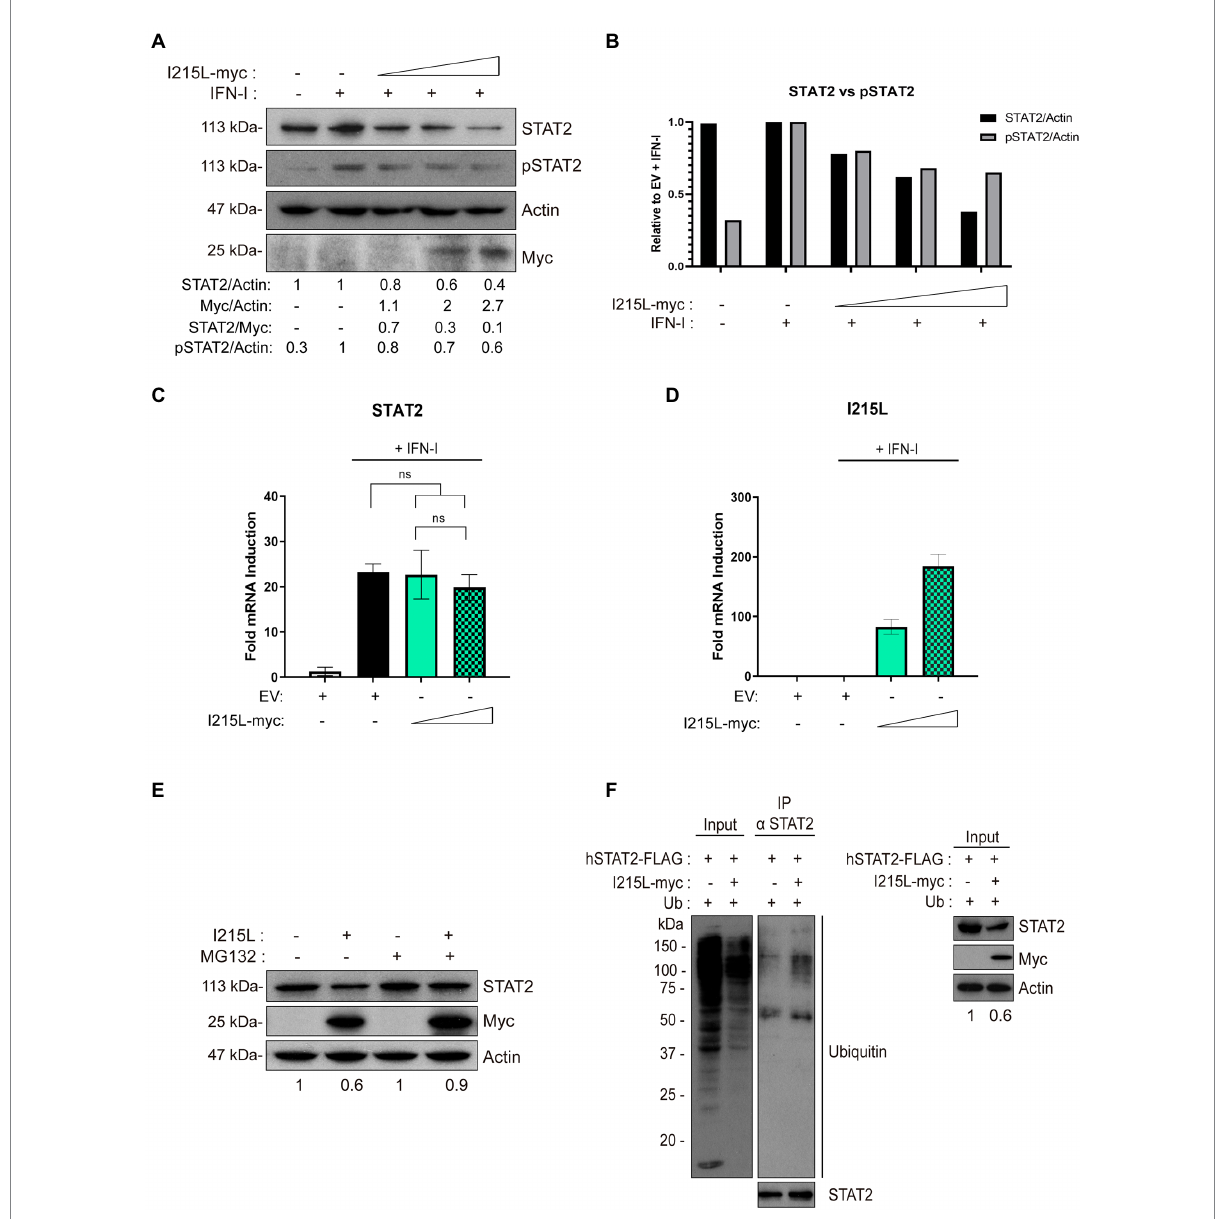
FIGURE 3 pI215L induces STAT2 ubiquitination and degradation. (A) STAT2 and pSTAT2 levels were analyzed in presence of increasing concentrations of pIRES-I215L-myc (0.25, 1, or 2.5 μ g/1 × 10 6 cells) or EV (2.5 μ g/1 × 10 6 cells) in HEK-293 by Western blot assay. Antibodies against STAT2, pSTAT2, myc and actin were employed. STAT2, pSTAT2, and pI215L-myc levels were quantified according with their actin levels and relativized with the EV control using ImageJ. The dose effect of pI215L-myc on STAT2 was quantified as STAT2/Myc. (B) Graphical representation of STAT2 versus pSTAT2 levels from the quantification of the Western blot analyzed samples corresponding to (A) . (C) STAT2 mRNA levels were analyzed in COS-1 cells transfected with EV (2.5 μ g/1 × 10 6 cells) or increasing concentrations of pIRES-I215L (0.5 or 2.5 μ g/1 × 10 6 cells) in absence or in presence of IFN-I by qRT-PCR. (D) I215L mRNA levels were amplified by qRT-PCR in the same conditions than (C) to verify the correct transcription of I215L in COS-1 transfected cells. All data reflect mean ± SEM ( n = 3). Data were statistically analyzed by using a Student t test (ns, not significant). (E) STAT2 levels were analyzed in presence or absence of the proteasome inhibitor MG132 (10 μ M) in pIRES-I215L-myc or EV HEK-293 T transfected cells (2 μ g/1 × 10 6 cells) by Western blot assay. Antibodies against STAT2, myc and actin were employed. STAT2 levels were quantified according with their actin levels and relativized with the corresponding EV control using ImageJ. (F) Immunoprecipitation of STAT2 in COS-1 cells transfected with EV or pIRES-I215L-myc. COS-1 cells were co-transfected with pCI-His-hUbiquitin (1 μ g/1 × 10 6 cells), hSTAT2-FLAG (0.4 μ g/1 × 10 6 cells) and either EV or pIRES-I215L-myc plasmids (2 μ g/1 × 10 6 cells). At 24 h post-transfection, cells were treated with IFN-I (500 U/mL) for 2 h. Cells were collected and lysed for STAT2 immunoprecipitation assay with A/G magnetic beads. Western blot labeling with anti-ubiquitin, anti-STAT2, anti-myc and anti- actin antibodies is